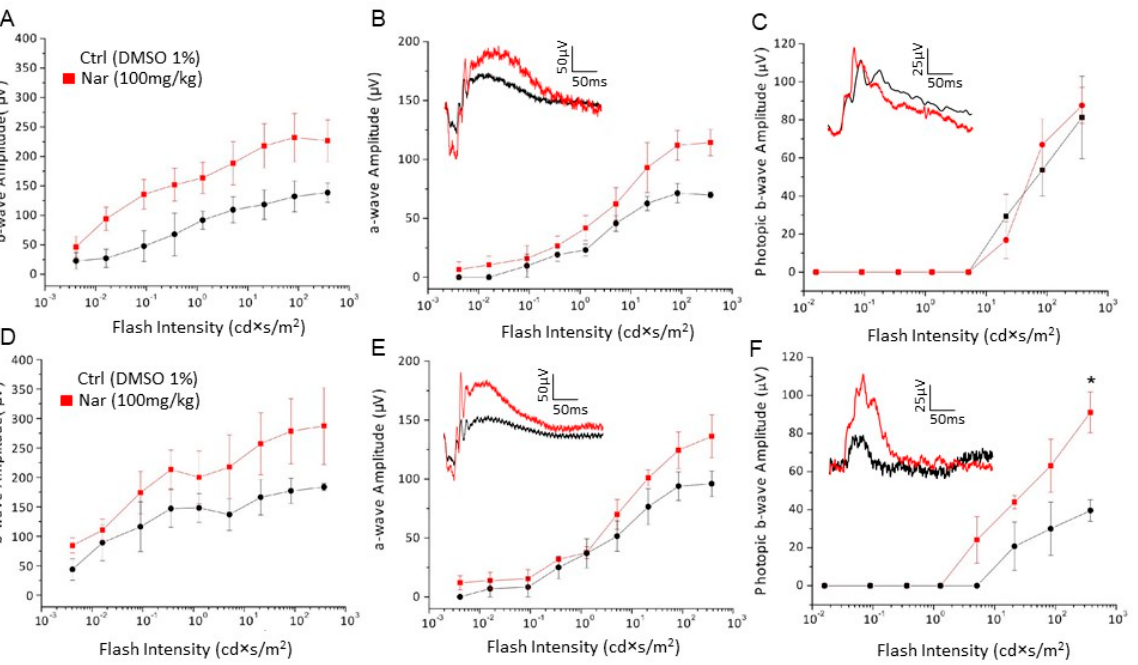
Figure 8. Naringenin preserves retinal function in older C57BL/6J mice. ( A – C ): Retinal function tested by recording scotopic and photopic ERG in 9-month-old mice treated with naringenin 100 mg/kg/day for three months. The curves show the amplitude respectively of scotopic b-wave ( A ) and a-wave ( B ) and photopic b-wave ( C ); ( D – F ): Retinal function tested by recording scotopic and photopic ERG in animals of 12 months treated with naringenin 100 mg/kg/day for six months. The curves show the amplitude respectively of scotopic b-wave ( D ) and a-wave ( E ) and photopic b-wave ( F ). The values shown represent the mean ± SEM; n = 6 for each group; Wilcoxon-Mann-Whitney Test statistical analysis (* p ≤ 0.05).